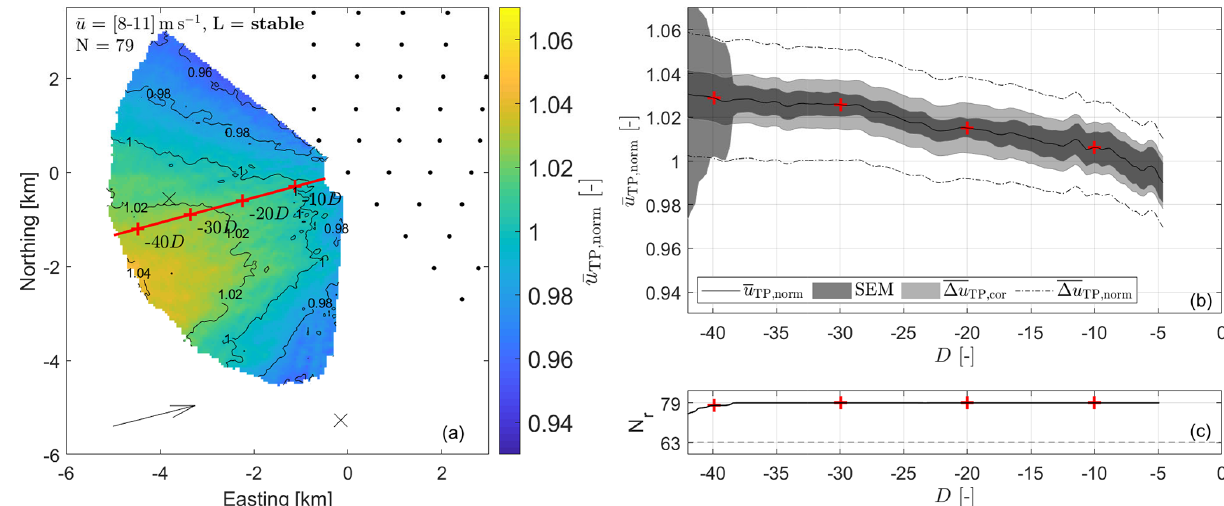
Figure 7. Scenario 4: analysis of lidar scans during stable atmospheric conditions and in cases with a high thrust coefficient with u = [8– 11]ms − 1 , χ = [250–260] ◦ , N = 79, χ = 256 ◦ , u GT58 = 9.23ms − 1 , P GT58 = 4.51MW, L med = 307m and σ χ = 2.78 ◦ . Contour lines in the flow field in (a) highlight the shape of the wind field upstream GT I. For further details on (a–c) refer to the caption of Fig.